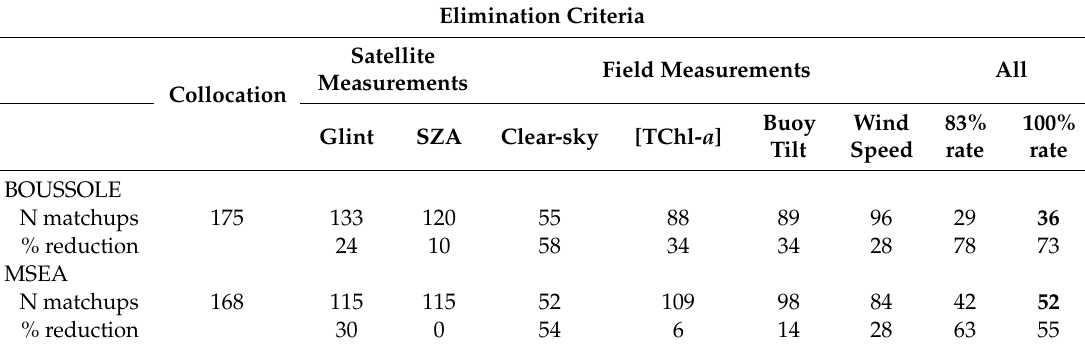
Figure 18. Potential number of valid system vicarious calibration (SVC) matchups at BOUSSOLE and MSEA. The open symbols are for the current buoy design and tilt values. The dark symbols are for tilt values that would be observed with the improved buoy design. The larger symbols on the left side of each panel show the average values for each time series. Table 2. Statistics of matchups reduction following quality criteria.